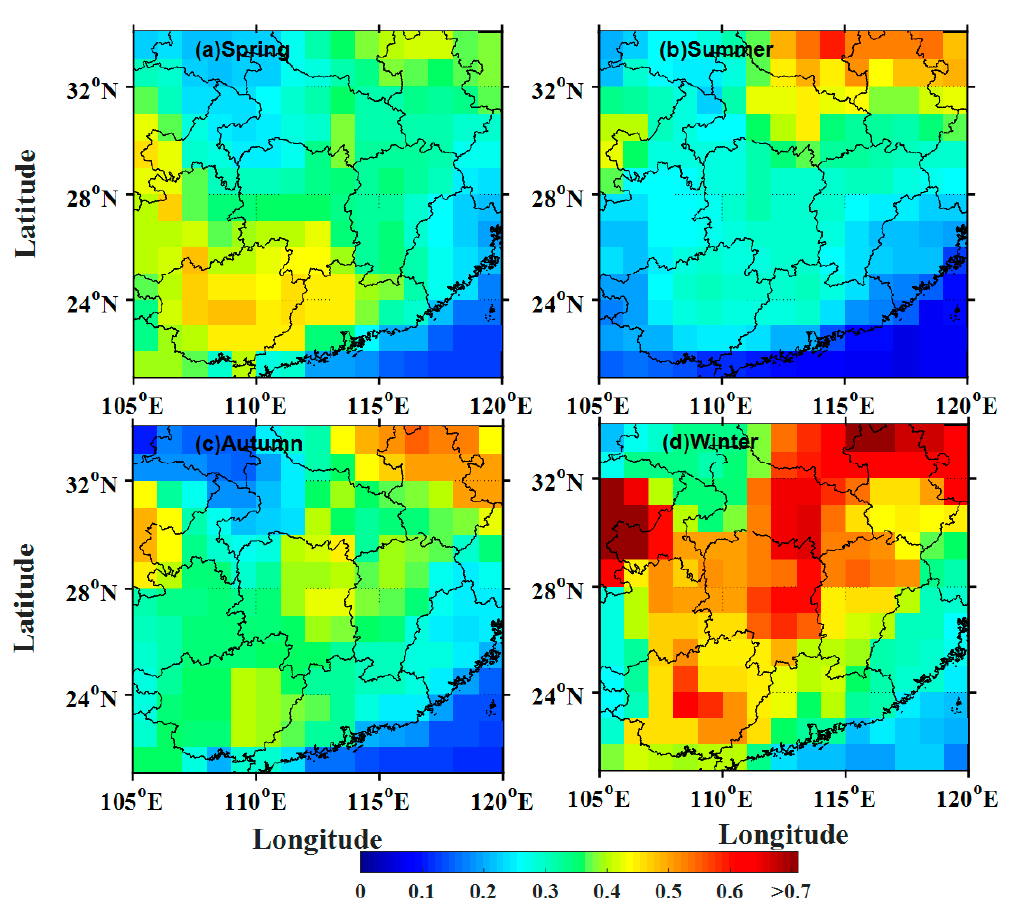
Figure 5. Annual average distribution of column aerosol optical depth with a spatial resolution of one degree in each season over central China from March 2007 to February 2016.